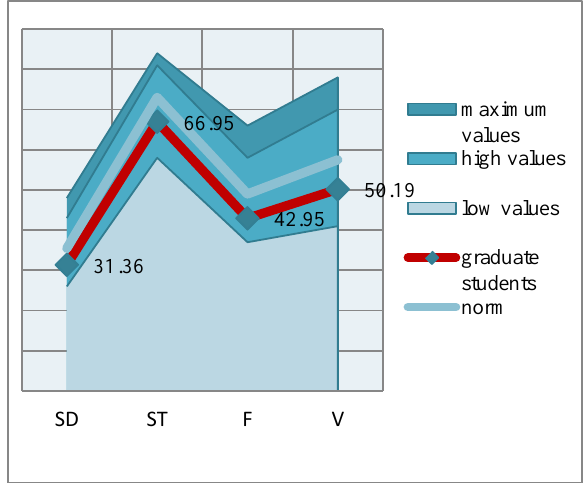
Fig. 11. Langle’s Existence Scale for a sample of graduate students.